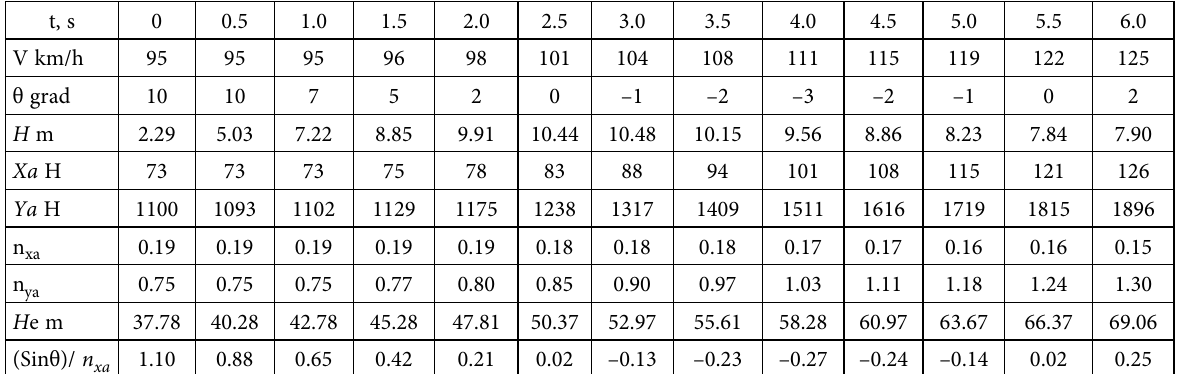
Table 2. Variation of flight parameters in a time dimension